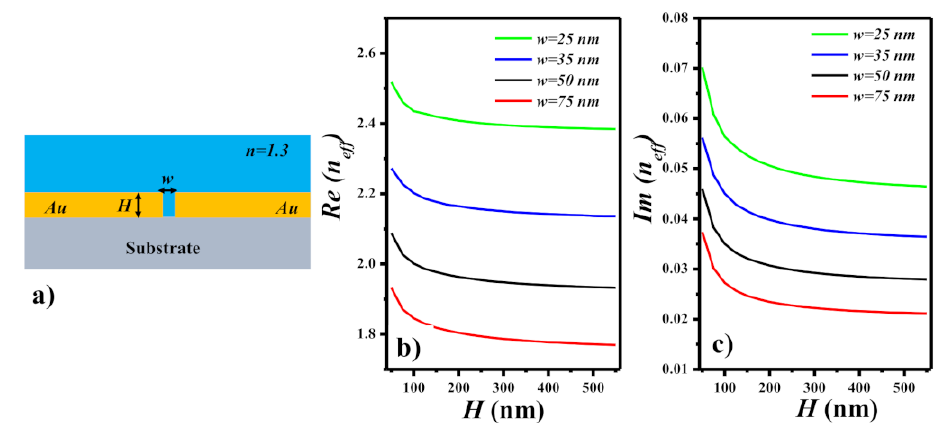
Figure 2. ( a ) Cross-sectional view of the MIM WG emersed in water ( n = 1.3). Determination of n eff concerning H and w of the MIM WG: ( b ) real part, ( c ) imaginary